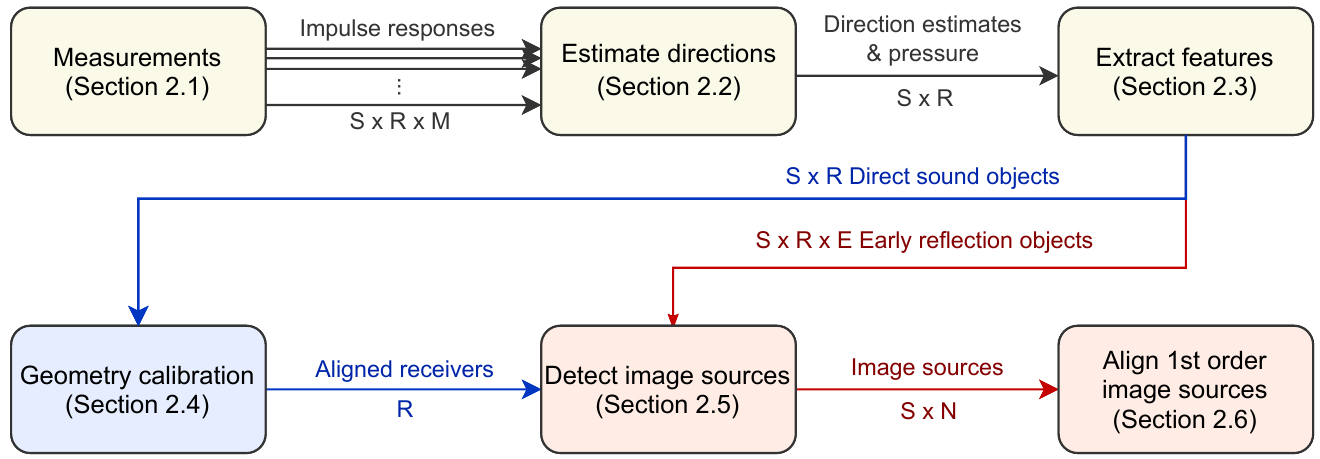
Figure 1. Image source detection method. Room impulse responses are measured between S sources and R receivers where the latter consists of M microphones. Each set of M impulse responses is analyzed for direction-of-arrival (DoA), resulting in a set of directional parameters for each source-receiver pair. These responses are extracted for the direct sound and E early reflections that are stored in their corresponding objects. The direct sound objects are utilized to align the receivers to a common coordinate frame. Using this frame, early reflection objects can be combined across measurements to form N image sources. Finally, the image sources can further be aligned with each other to find more accurate location estimates for first order image